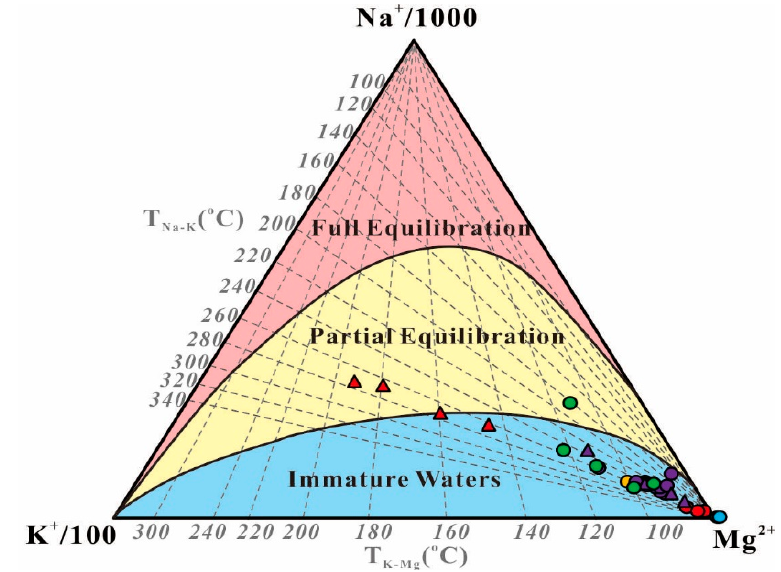
Figure 7. Na–K–Mg trilinear equilibrium diagram of the geothermal waters in the XFZ [28]. Legends are followed by those in Figure 5.